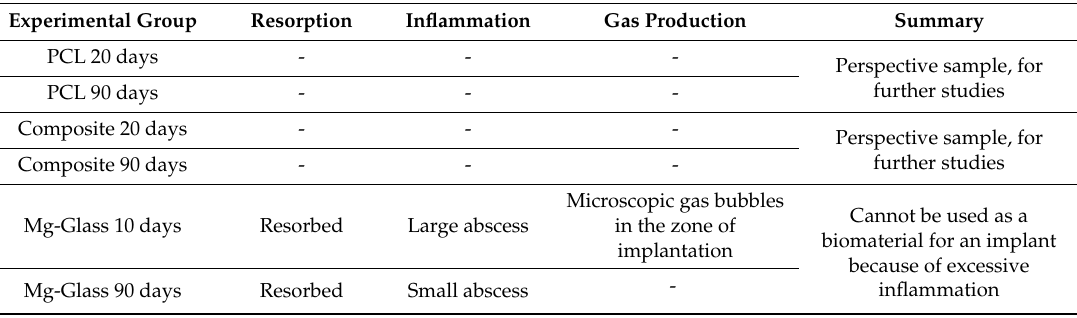
Table 3. Resultsof the in vivo